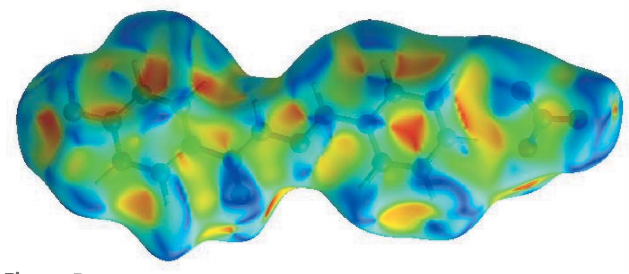
Figure 5 Hirshfeld surface of the title aroyl hydrazone Schiff base salt plotted over shape-index.